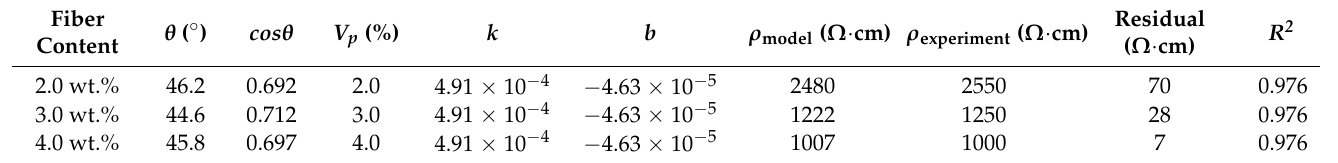
Table 3. Values of the fitting parameters of the model with experimental